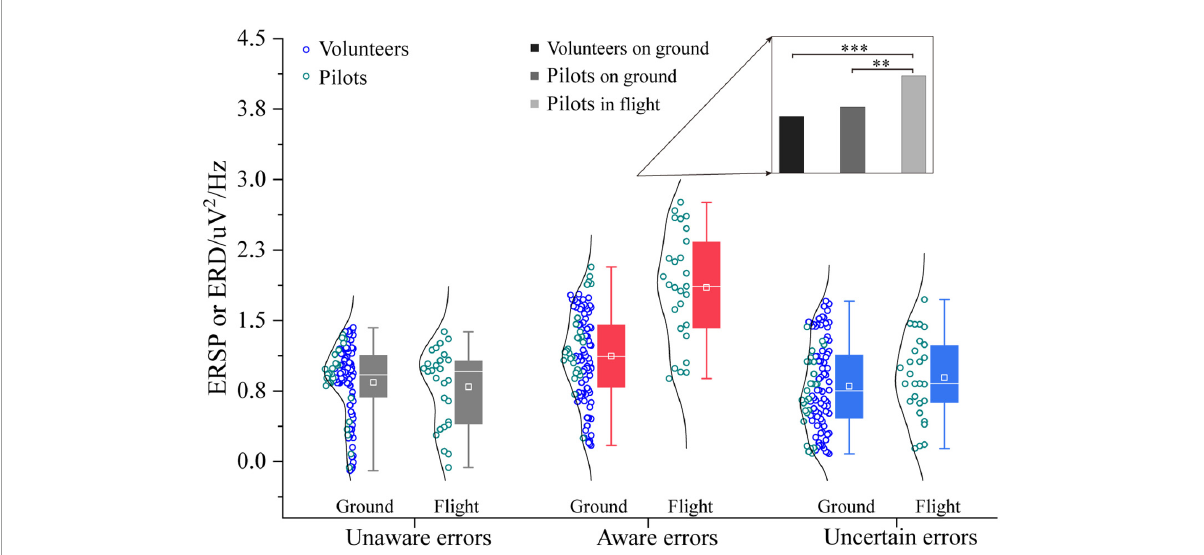
FIGURE8 Differences in α -ERS between pilots and volunteers in multiple error awareness on the ground or in flight environment. The squares in the box plots indicated the mean values, the white horizontal lines indicated the medians, and both ends indicated the maximum and minimum values ( ∗∗ p < 0.001, ∗∗∗ p < 0.0001).